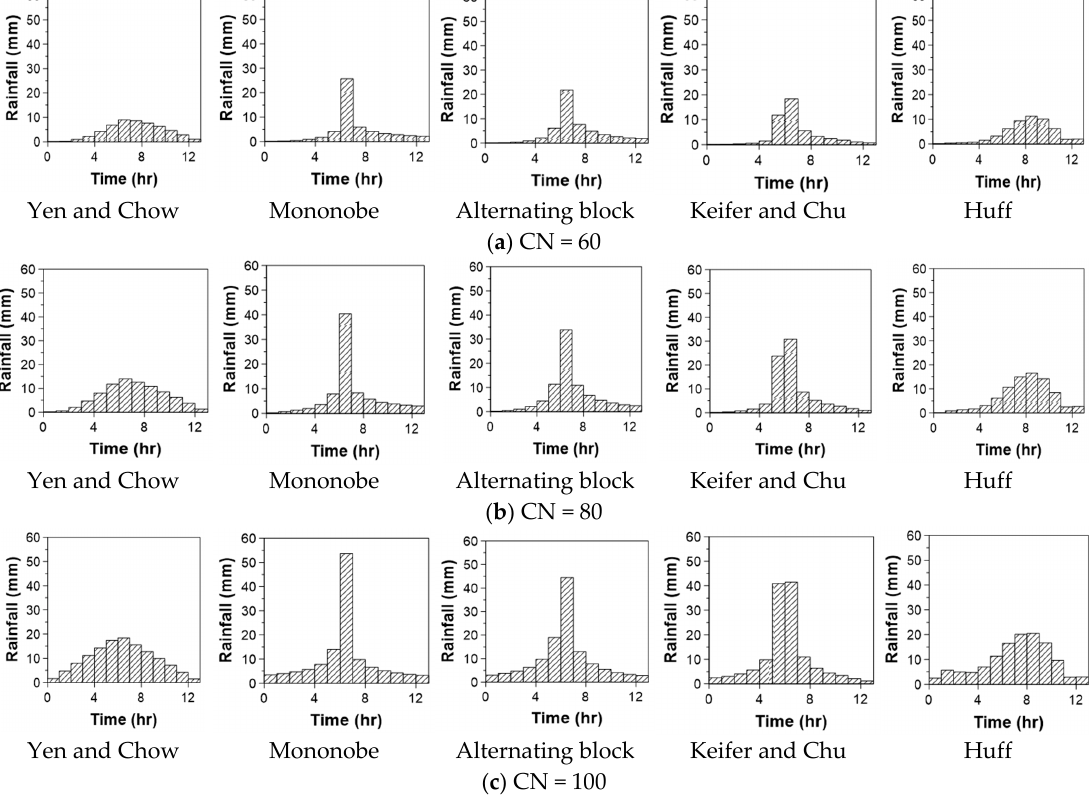
Figure 6. Comparison of effective rainfall temporal distributions of model and the annual maximum rainfall event in 1997.